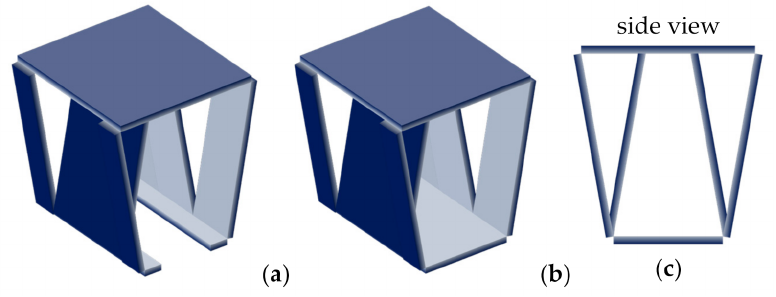
Figure 6. 4th design: ( a ) preliminary open design; ( b ) final closed design; ( c ) side